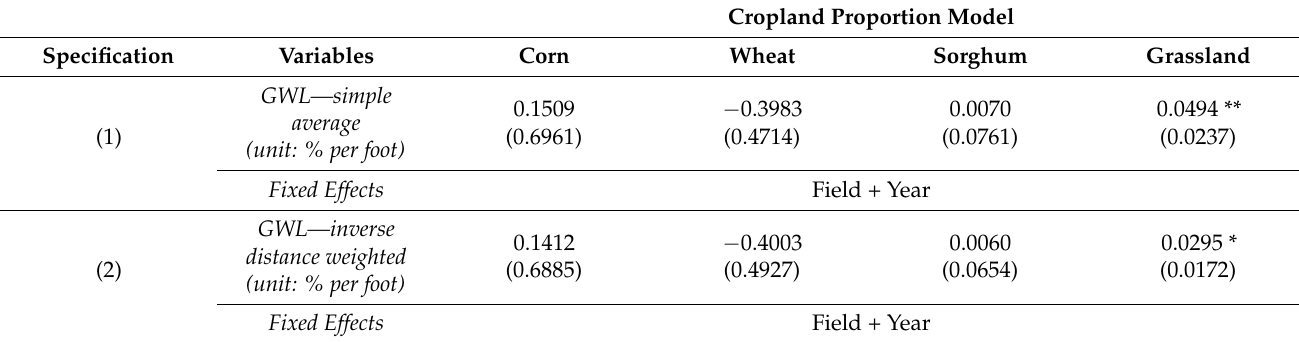
Table 3. Estimated average marginal effects of groundwater level